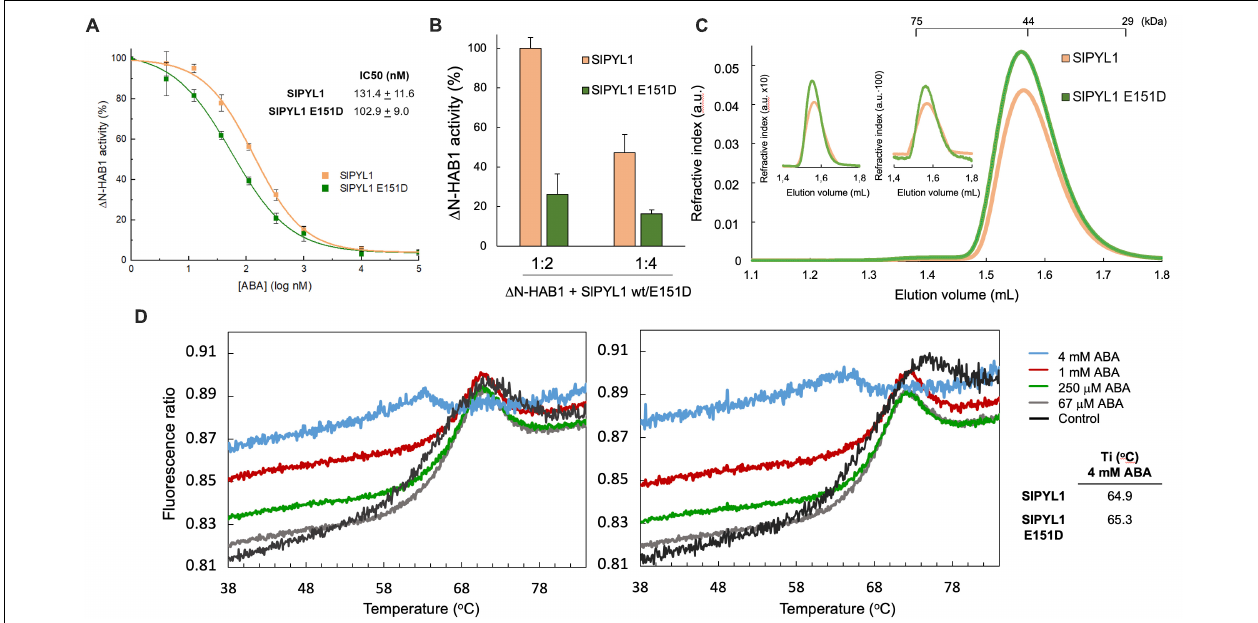
FIGURE 1 | Biochemical properties of SlPYL1 E151D. (A) Determination of the IC50 for inhibition of HAB1 by ABA and SlPYL1 or SlPYL1 E151D at 1:2 molar proportion of HAB1:SlPYL1. (B) HAB1 activity in the presence of molar ratios of HAB1:SlPYL1 or HAB1:SlPYL1 E151D of 1:2 and 1:4. 100% of activity is referred to 1:2 HAB1:SlPYL1wt. (C) Elution profile of SlPYL1 and SlPYL1 E151D, loading 60 (main profile), 6 or 0.6 microg of protein (inset). The positions of the molecular weight markers are indicated. (D) Thermal denaturation profiles of (left) wild-type and (right) mutant SlPYL1 E151D proteins (6 mM) in the absence or presence of increasing ABA concentrations (legend). The inflection temperature at 4 mM ABA is